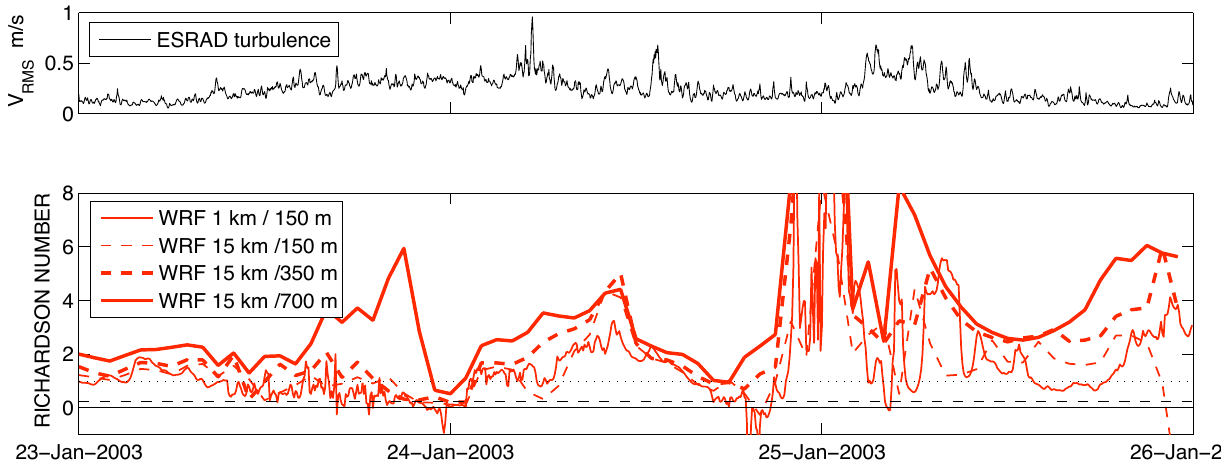
Fig. 9. Comparison between turbulent velocities measured by ESRAD and WRF model estimates of the bulk Richardson number using different horizontal (1 or 15km) and vertical (150, 350 or 700m) resolutions. Measurements show the mean V RMS between 2000 and 5000m heights, model results the minimum Richardson number between the same heights.